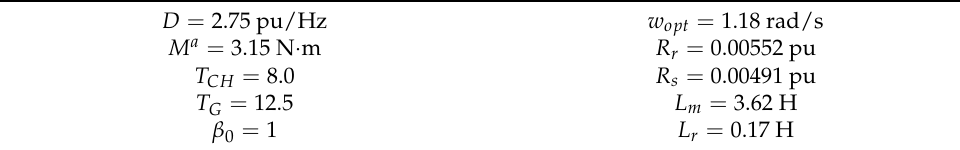
Table 2. Model parameters of power system.